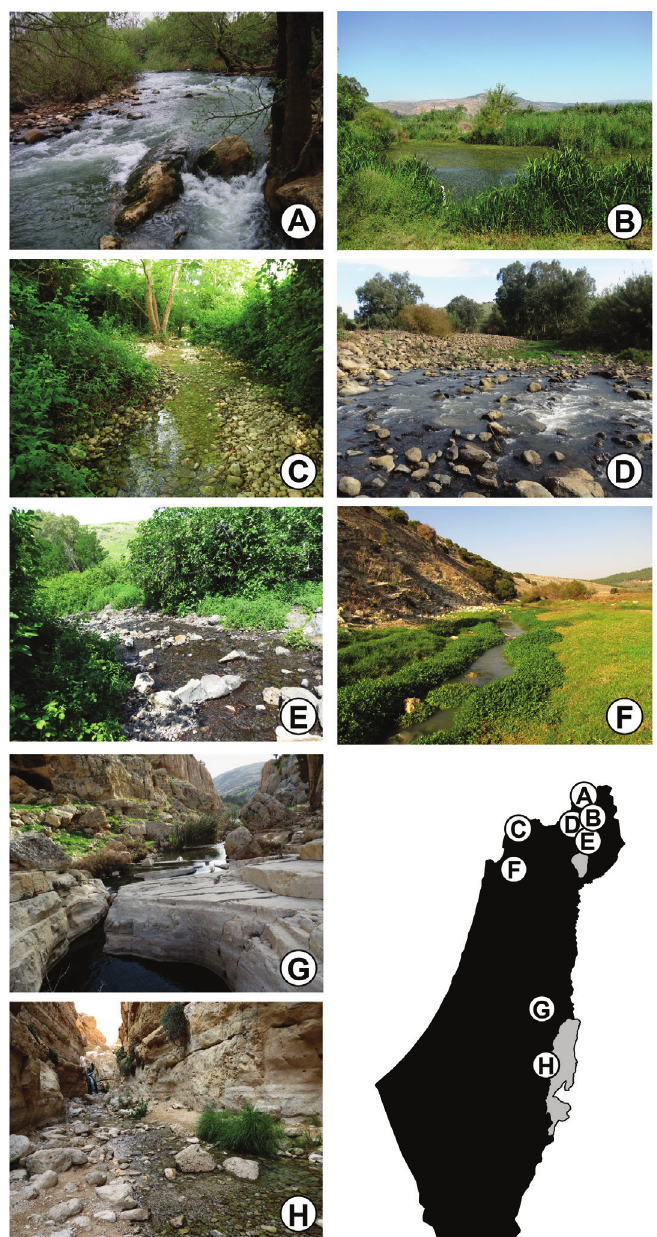
Figure 2. Typical Baetis habitats in Israel and the Palestinian Authority: A Senir Stream, a main source of the Jordan River B Hula nature reserve, a marshland habitat C Keziv Stream, a pristine stream in a forested area in the Upper Galilee D Ateret Fortress, a site in the Upper Jordan River system E Maymon Spring, a small spring-fed brook in the Upper Jordan River system, the Golan Heights F Zippori Stream, a lowland stream in the Lower Galilee G Perat Stream (Wadi Qelt) in the eastern Judean Mountains H Arugot Stream, a desert stream in the arid water system of the Dead